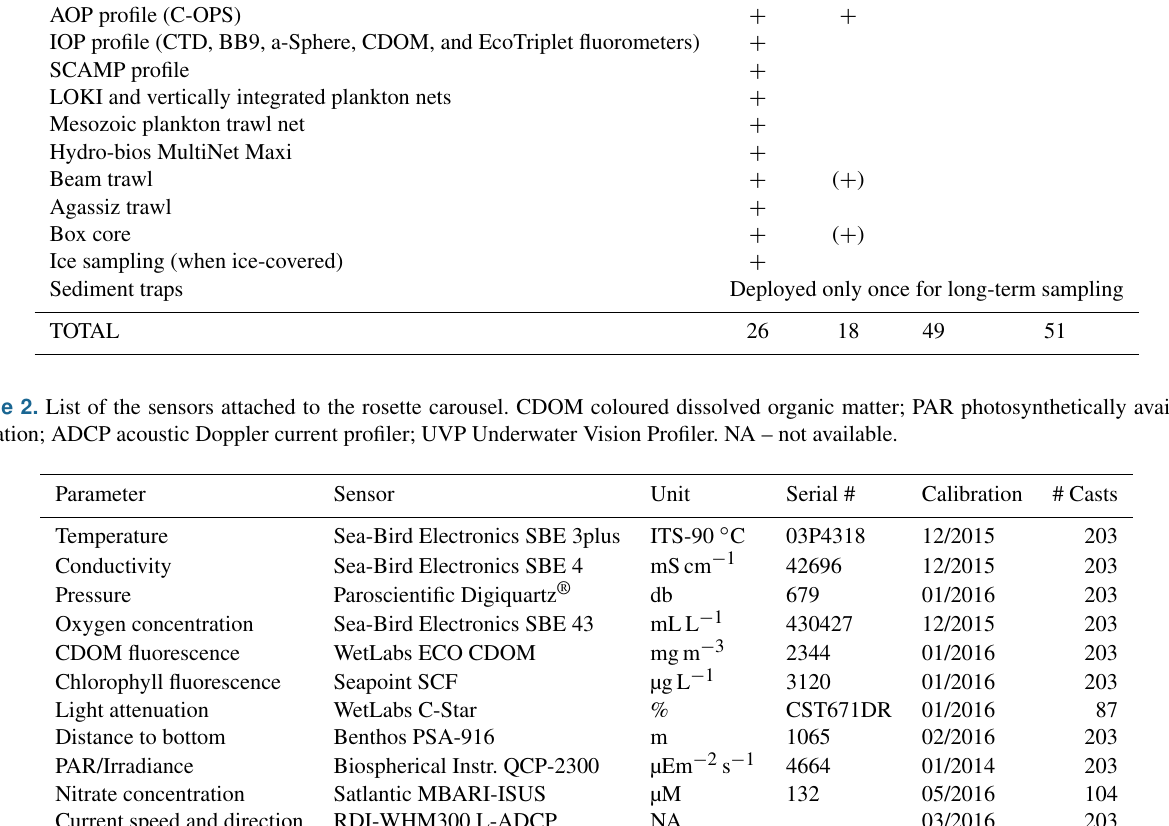
CTD cast (see Table 2 for sensors list)